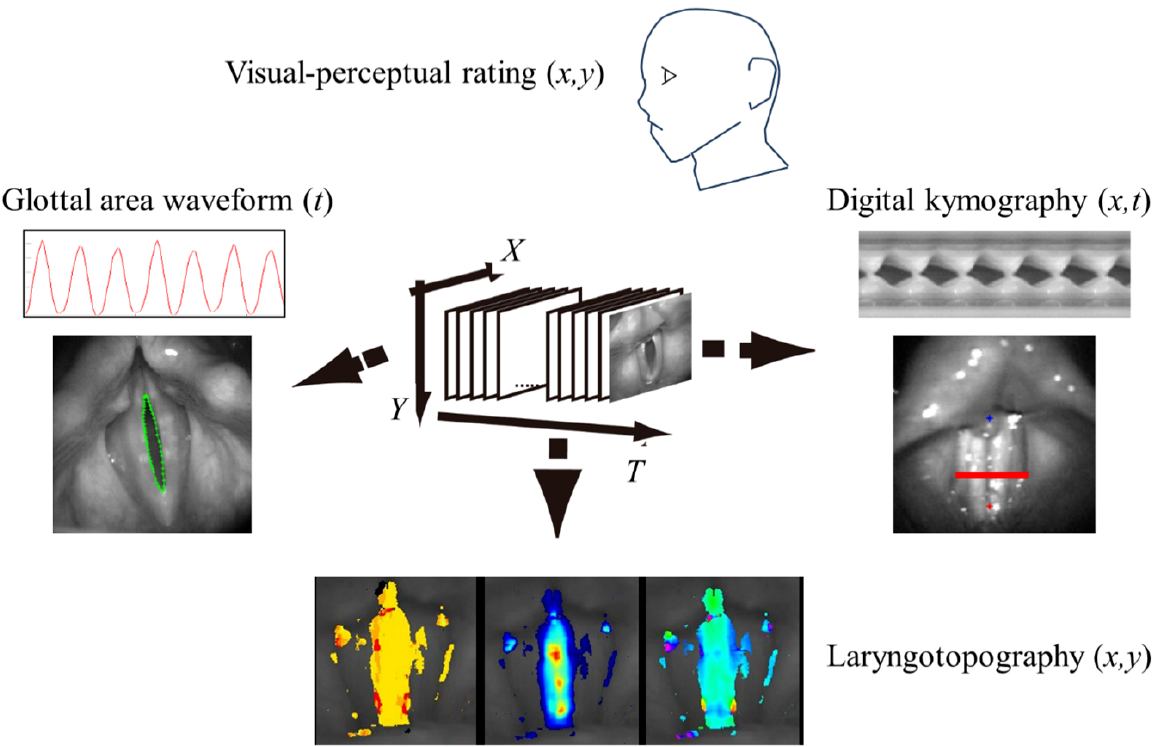
Figure 1. Analysis Method. HSDI data are composed of mediolateral ( x -axis), longitudinal ( y -axis), and temporal ( t -axis) dimensions. Visual-perceptual rating is easy and effective in assessing x - and y -axis data although it is subjective and not apt for temporal analysis. Digital kymography is a classical, popular method that is effective in the quantitative assessment of x - and t -axis data. Laryngotopography is an intuitive easy-to-understand method that enables spatial assessment ( x - and y -axis data). Glottal area waveform is another classical popular method that allows quantitative evaluation of temporal change of glottal area. Combining these methods guarantees thorough analysis of HSDI